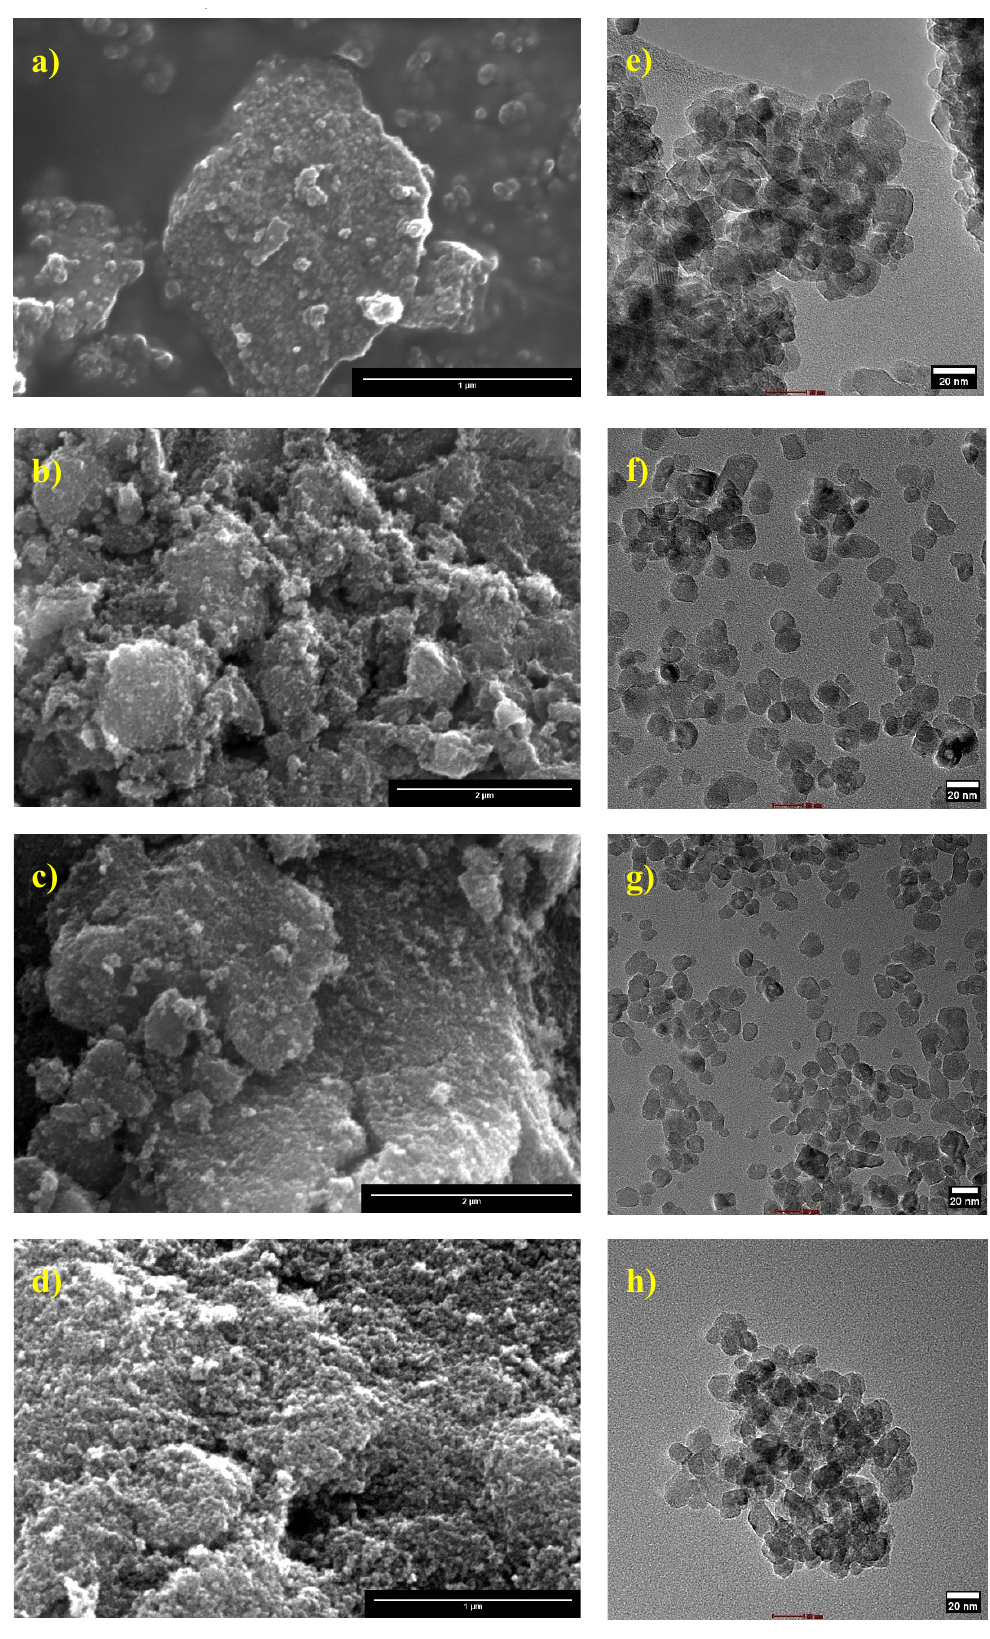
Figure 6. Scanning and transmission electron microscopy of ( a , e ) pure TiO 2 , ( b , f ) TiO 2 -A, ( c , g ) TiO 2 -B, and ( d , h ) TiO 2 -C, respectively. Table 2. Energy dispersive X-ray spectroscopy (EDX) analysis of all samples.